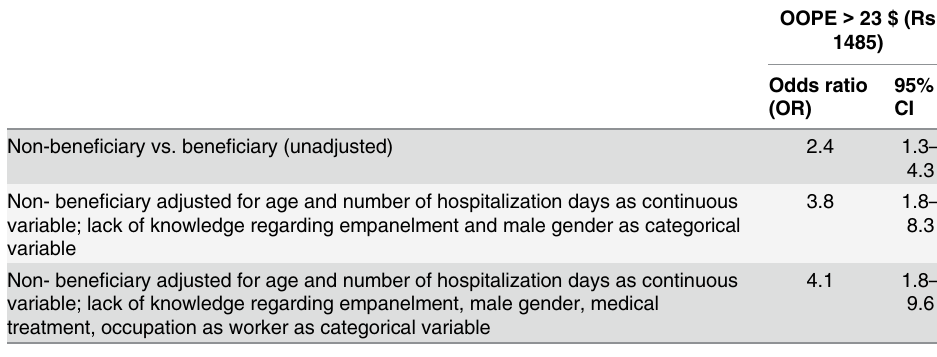
OOPE > 23 $ (Rs 1485) Odds ratio 95% (OR) CI